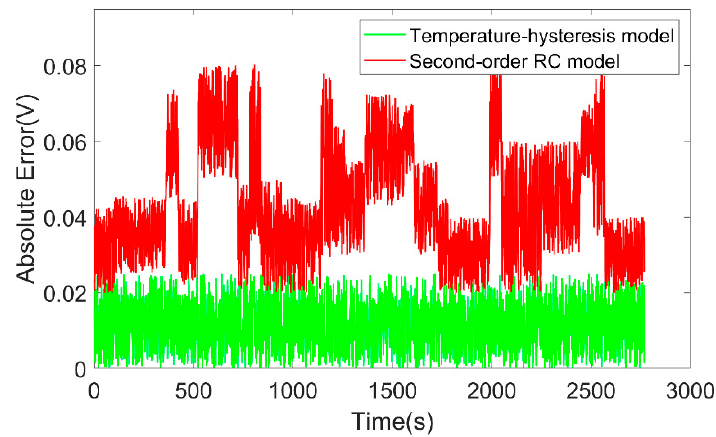
Figure 17. Battery models output error curve under variable temperature conditions.